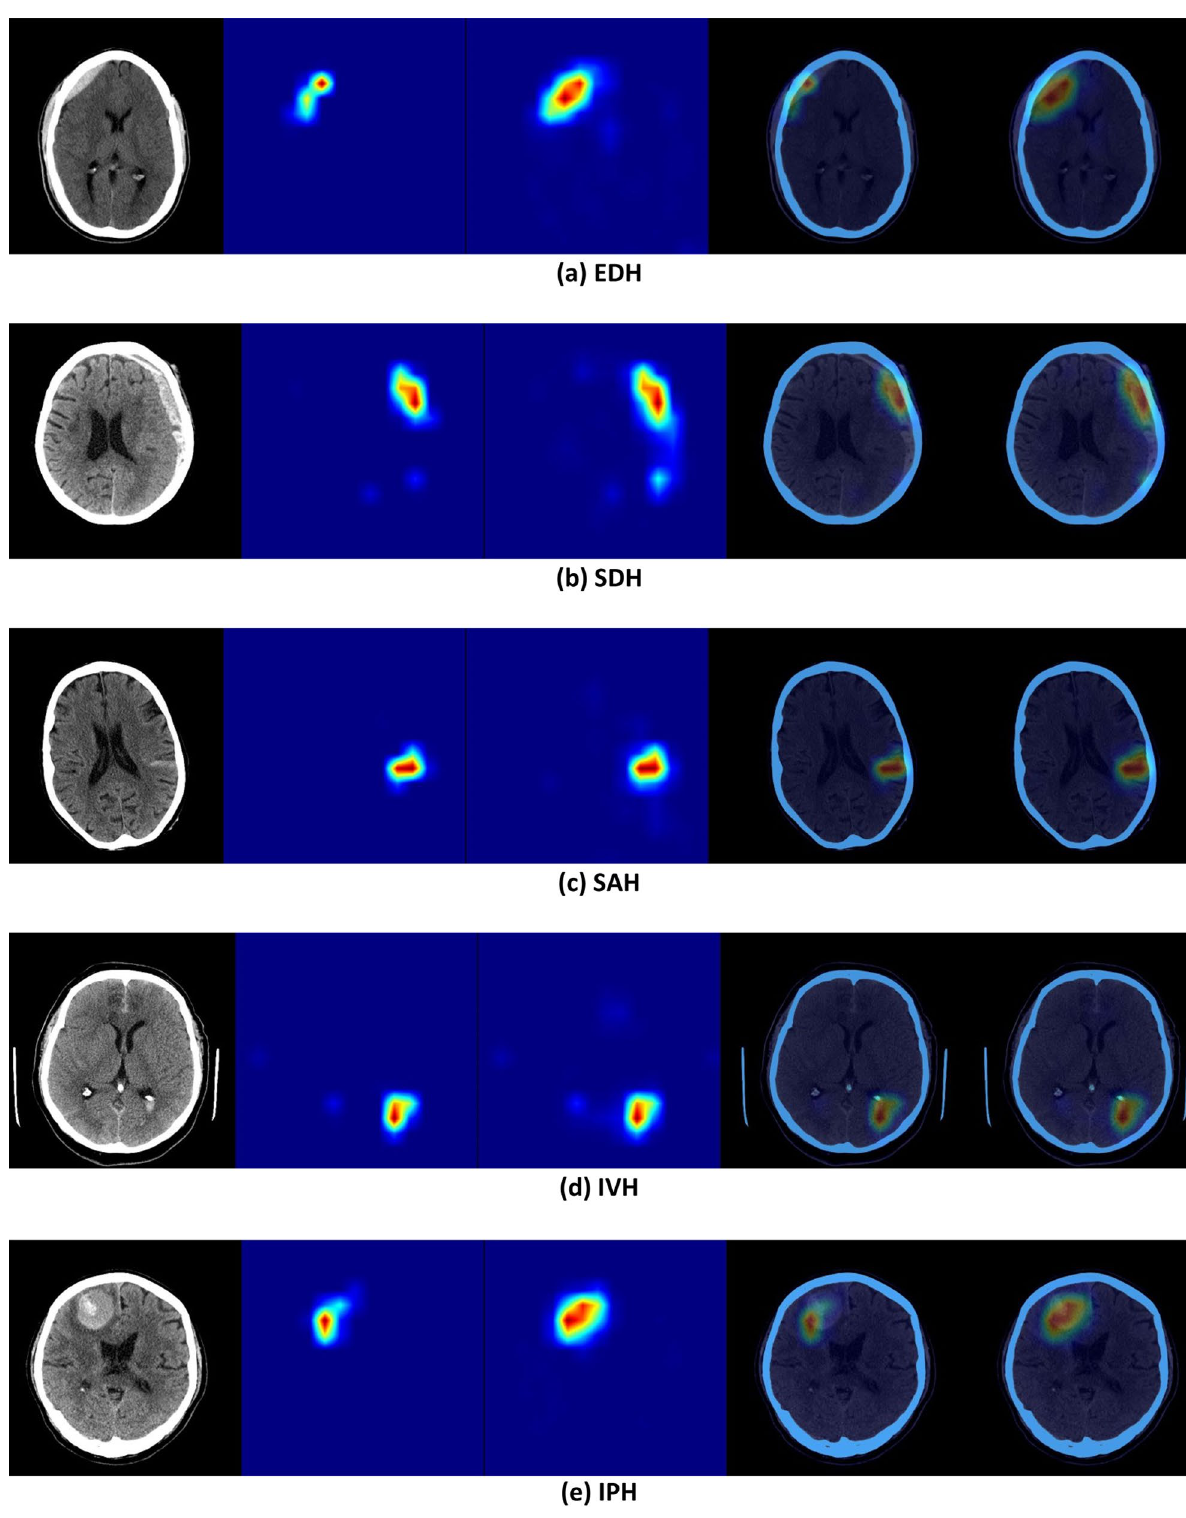
Figure 2. Visualization of feature maps from layer 4 (the layer before adaptive averaging pooling) in SE-ResNeXt-50 (32 × 4d). Left: Input head CT image; Middle left: GradCAM heat map; Middle: GradCAM++ heat map; Middle right: GradCAM result superimposed on CT image; Right: GradCAM++ result superimposed on CT